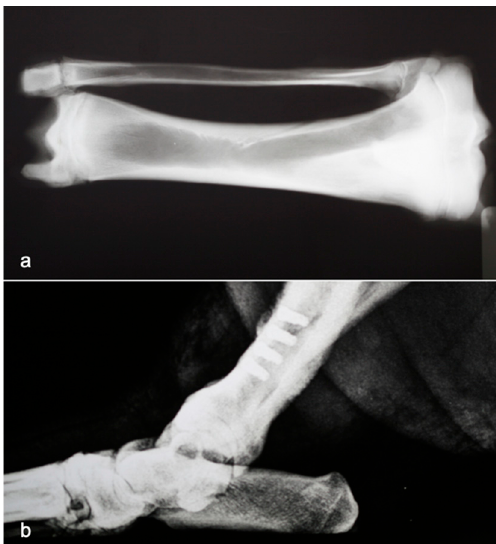
Figure 1. X-ray tibia of minipig showing the relationship between cortical and cancellous bone ( a ). X-ray tibia with implants ( b ).